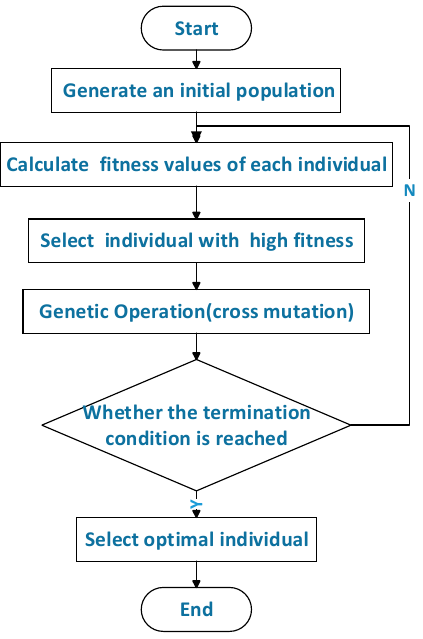
Figure 3. Necessary iterative steps of the traditional genetic algorithm.